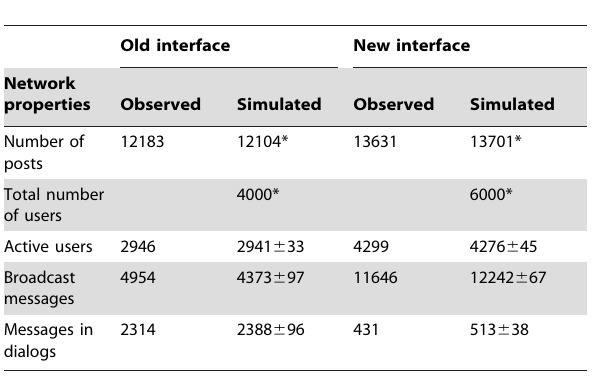
Table 4. Comparison of basic network parameters between the observed Gazeta Wyborcza fora and computer